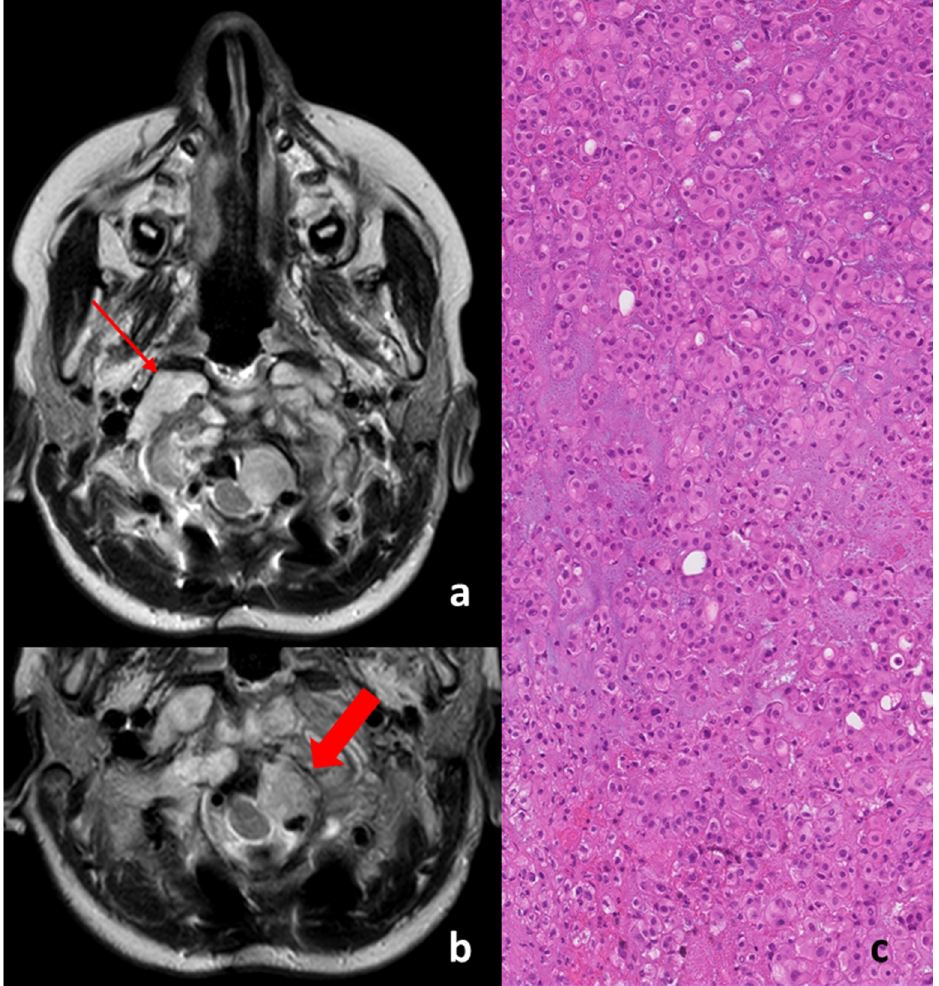
Figure 2. Pre-proton therapy images (representative T2-weighted MRI axial views ( a ) and ( b )) and histologic examination after biopsy at the first diagnosis ( c ).